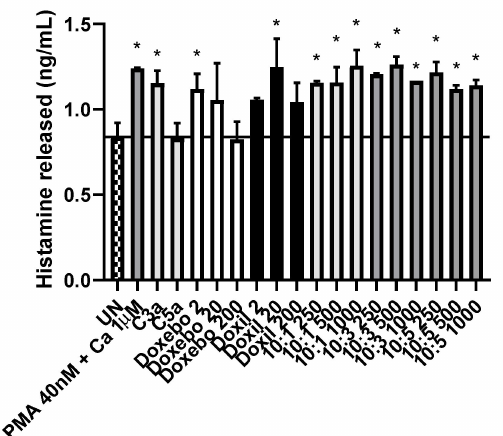
Figure 7. Quantity of histamine released following incubation for 24 h. Concentrations shown are stated in ng/mL unless otherwise stated. C3a and C5a were each used at a concentration 50 nM. Mean values used are calculated from n = 3. * denotes p < 0.05. Chequered bar represents a negative control (untreated), white represents unloaded Doxebo formulation, black represents loaded Doxil formulation, varying greys represents additional treatments containing materials such as PMA, calcium ionophore, C3a, C5a and liposomes.